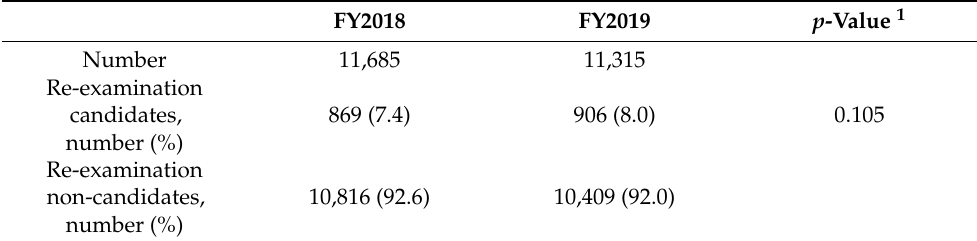
Table 1. Rate of CKD re-examination candidates.